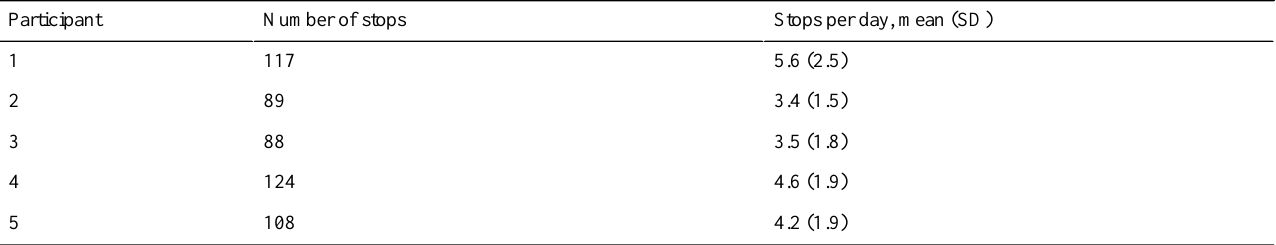
Table 3. Summary statistics of 4 weeks of travel diary recordings for the